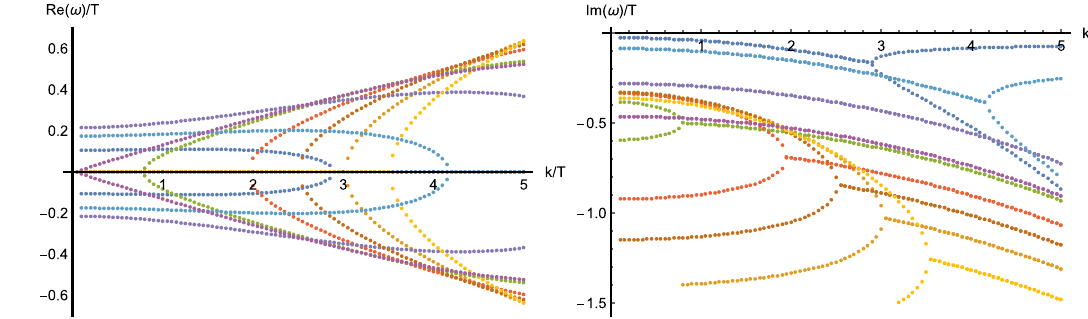
Fig. 5 Dispersion relations of the lowest-lying modes for J = 0 . 25, α = 1, T /μ = 0 . 1 and λ ∈ [ 0 . 0001 , 0 . 15 ] , i.e. β ∈ [ 0 . 65 , 50 ] (yellow-blue). The critical value of β can be fixed as β c ≈ 3 . 049